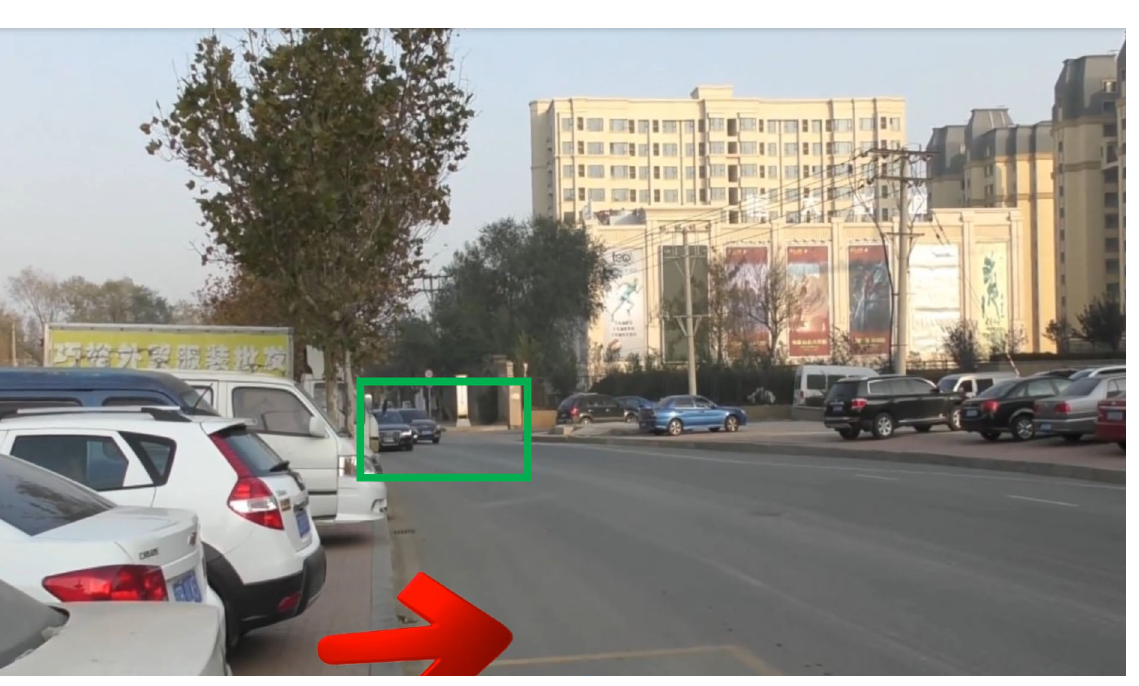
Fig 1. Dangerous vehicle AOI in different traffic scenarios. http://doi.org/10.6084/m9.figshare.19149749. https://doi.org/10.1371/journal.pone.0267309.g001 PLOS ONE | https://doi.org/10.1371/journal.pone.0267309 May 6,